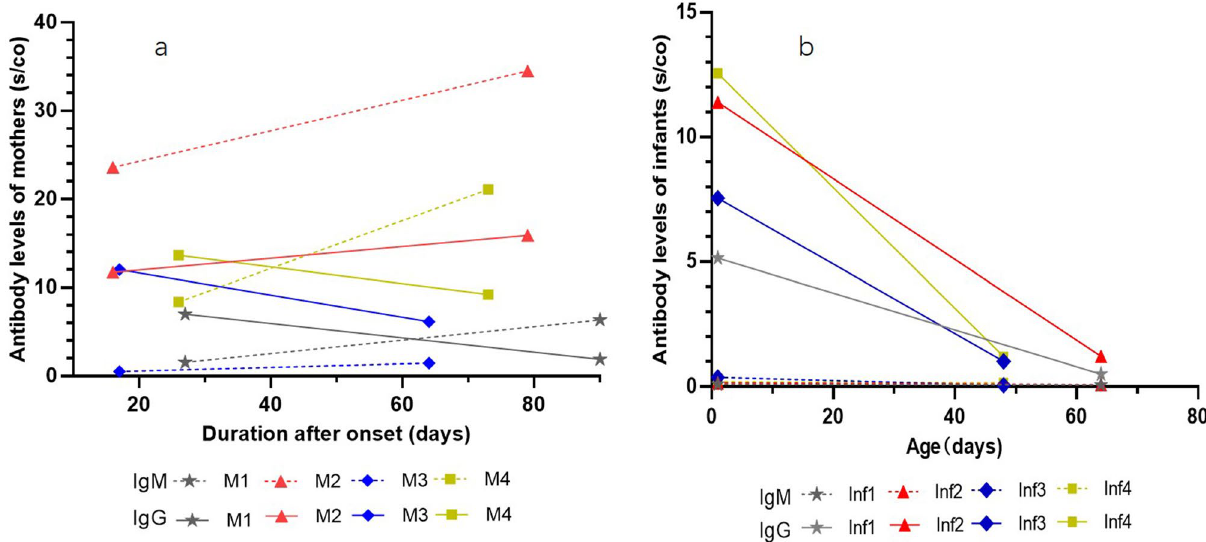
Figure 2. Dynamic changes of serum antibodies to SARS-CoV-2 in 4 COVID-19 mothers and their 4 infants. Antibody concentration ≥ 1.0 s/Co was defined as positive. Solid lines mean levels of IgG, dotted lines mean levels of IgM. M cases of mothers, Inf cases of infants. ( a ) antibodies levels of mothers; the serum antibodies detection interval of mother 1 was on the day of 27 and 91, mother 2 on the day of 16 and 71, mother 3 on the day of 17 and 64, and mother 4 on the day of 26 and 73 after onset. ( b ) antibodies levels of infants; the serum antibodies detection interval of four infants was on the day at birth and the day of 63, 63, 46 and 31 after birth, the same day with their mothers respectively. All 4 infants were formula